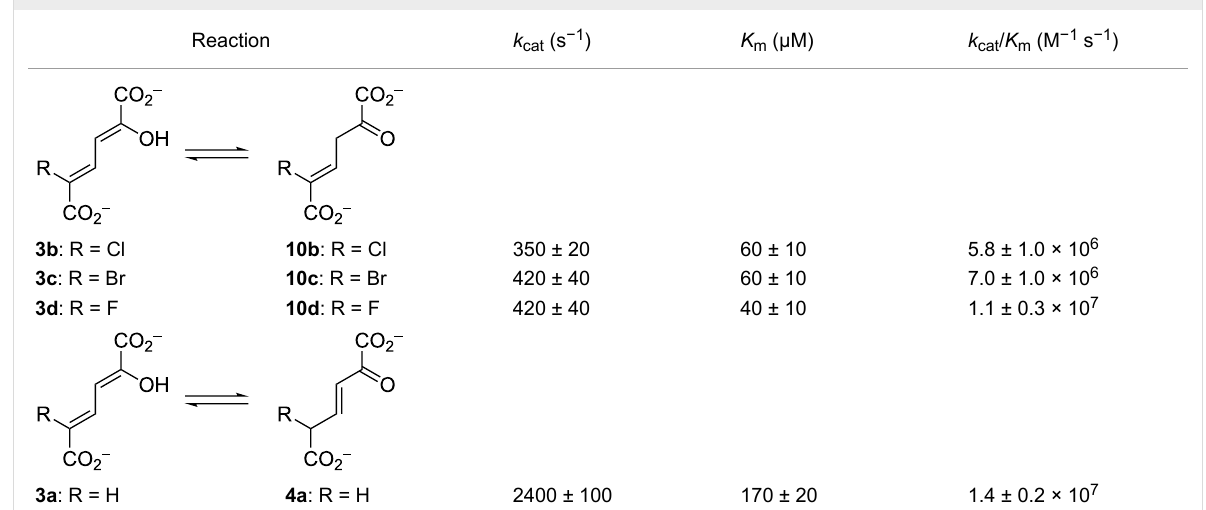
Table 2: Kinetic parameters for Lc 4-OT using 3a – d . a